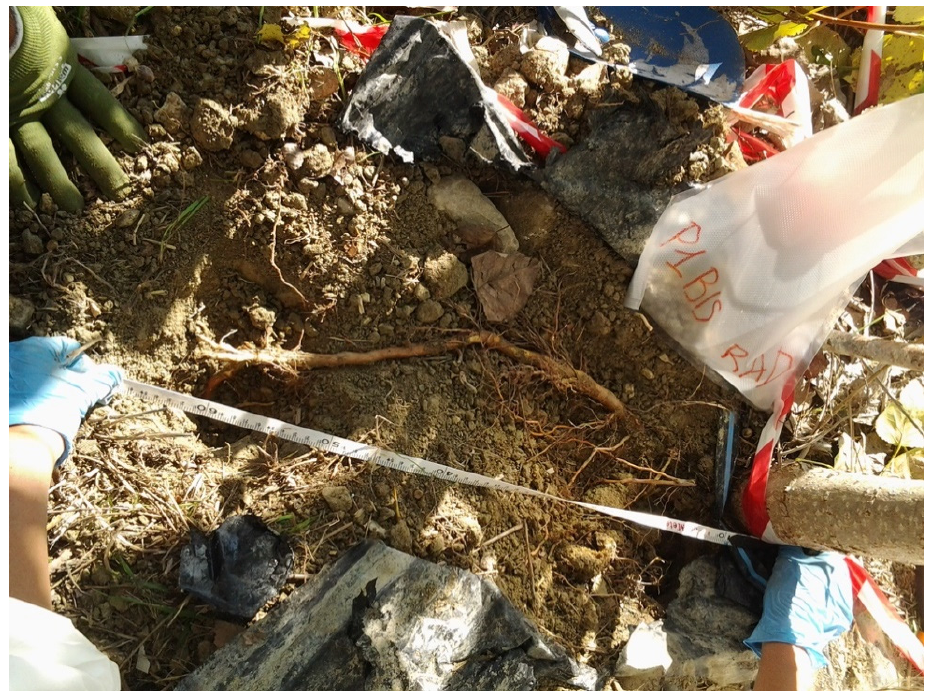
Figure 2. Root system of P1bis target tree.